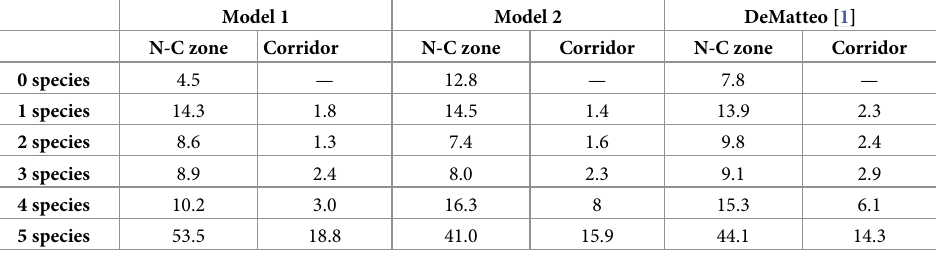
Table 4. The proportion (%) of suitable habitat across the range of potential species richness (0–5 species) within the ~1.5M ha of the northern-central (N-C) zone in Misiones, Argentina, as well as the proportion (%) of total suitable habitat (0–5 species) captured by ~400,000 ha multispecies biological corridor modelled by DeMatteo [1].